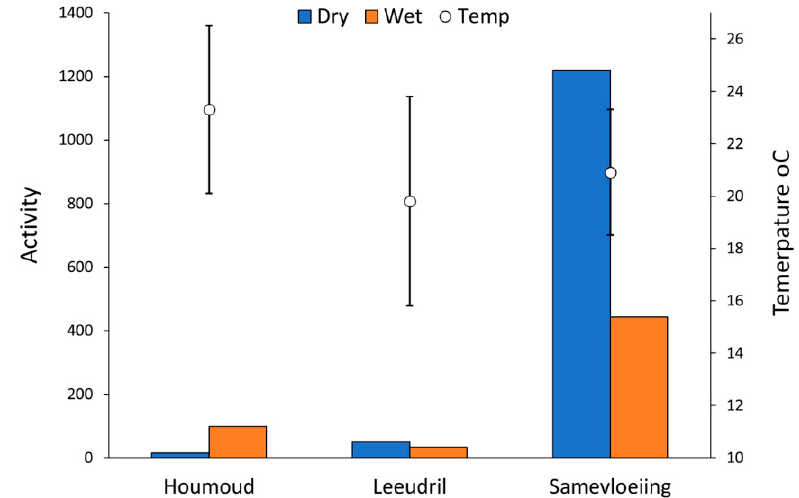
8 of 11 botswanae (LAEBOT). WH = Water Hole, DS = Dry Site, TW = Twee Rivieren gate, a dry site paired with Samevloeiing WH. 3.3. Wet versus Dry Site Comparisons For our wet versus dry sites, pooled nightly bat activity was significantly higher at dry sites ( Χ 2 = 182.5, P < 0.001). Only at Houmoed was activity higher at the water source than its paired dry